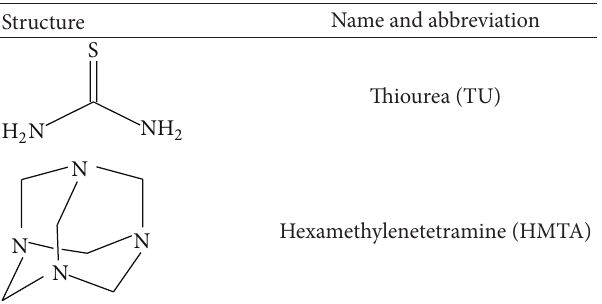
Table 1: Chemical structures and names of the studied thiourea and